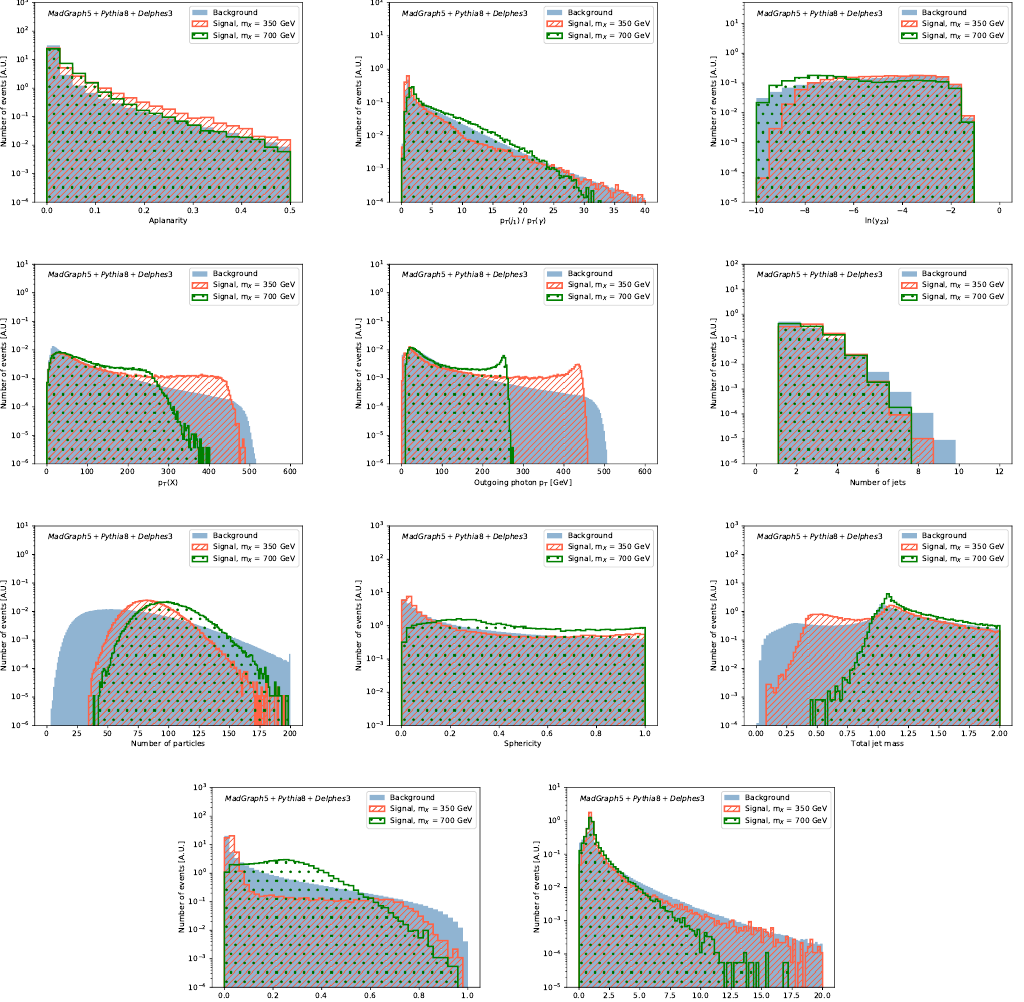
Figure 13. Event-level variables used in training, overlaying background and both signal mass hypothesis